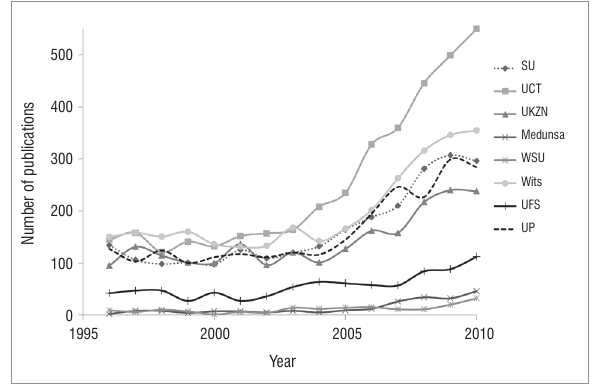
Figure 10: Medical-related publication output from the eight medical institutions in South Africa during